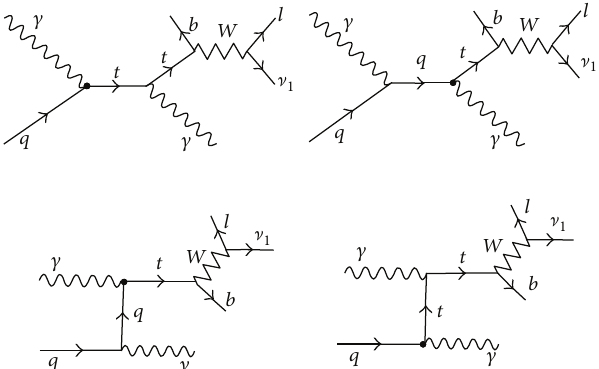
Figure 1: Tree level Feynman diagrams for the process 𝛾𝑞 → 𝑡𝛾 → 𝛾 . 𝑏ℓ + ] ℓ